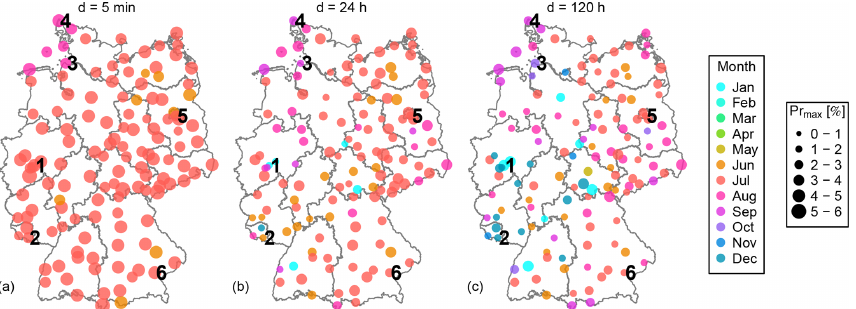
Figure 5. Maximum probability of the annual 0.9 quantile q p , d being exceeded in 1 month and months when the maximum occurs at each of the considered stations for three different durations. Dividing the probability values by the annual exceedance probability 1 − p = 0 . 1 yields the conditional probability. Therefore a value of Pr max = 5% can be interpreted as 50% of the exceedances of q p , d occurring in a single month. Numbers indicate the locations of example stations, presented in more detail in Fig.